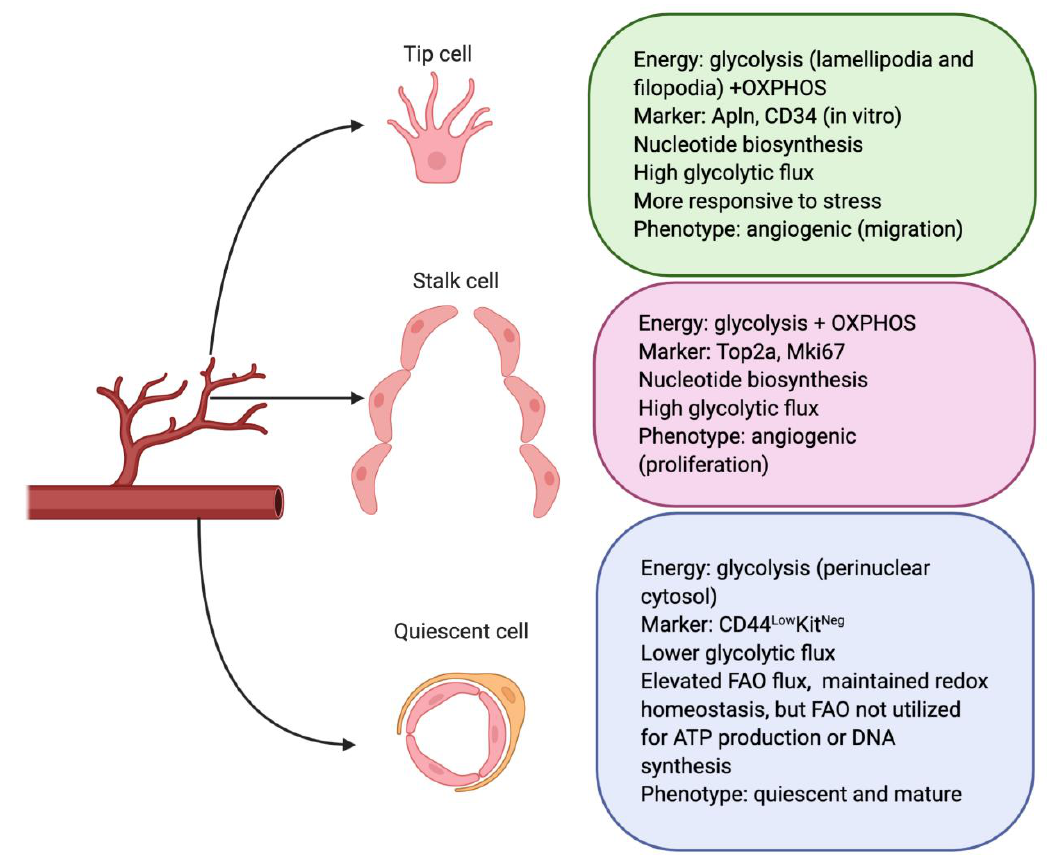
Figure 1. Differential metabolic features in three major endothelial cell (EC) populations. According to the phenotypes of ECs, they can be classified into tip cells, stalk cells, and quiescent cells during angiogenesis. Tip cells grow from the pre-existing vascular bed and are highly responsive to microenvironmental signals for migration. Stalk cells are highly proliferative and follow the tip cells to form a vessel lumen. Quiescent cells maintain vascular homeostasis. Angiogenic ECs show upregulated glycolysis gene signatures during the angiogenic switch to meet their metabolic demands. Quiescent ECs lower their glycolytic flux (35–40%) and use fatty acid oxidation (FAO) flux to maintain energy homeostasis. OXPHOS: oxidative phosphorylation.